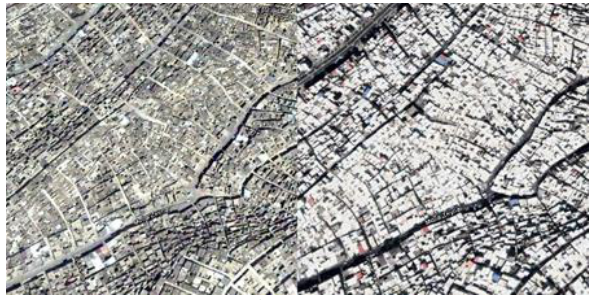
Figure 2. Urban roof covers change in